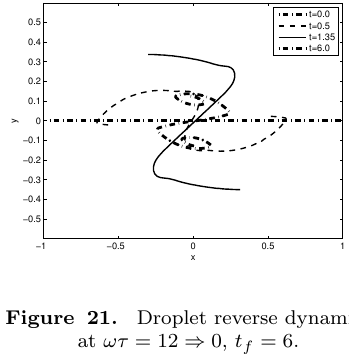
Figure 21. Droplet reverse dynamics at ωτ = 12 ⇒ 0, t f = 6.